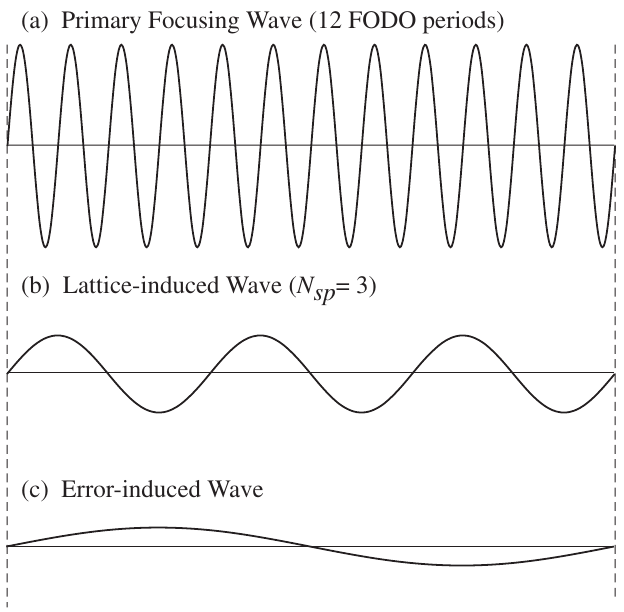
FIG. 4. Rf waveforms employed in the S-POD resonance ex-